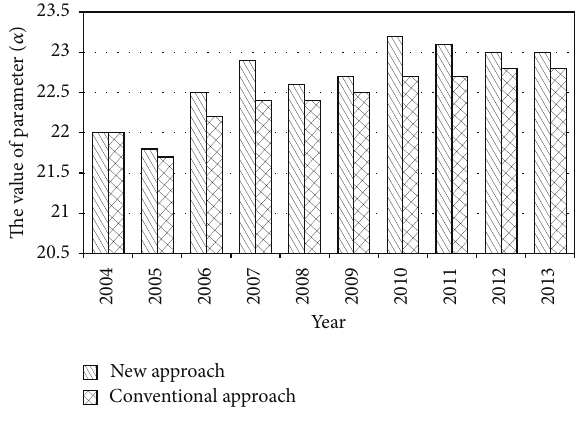
Figure 2: The value of parameter ( 𝛼 ).